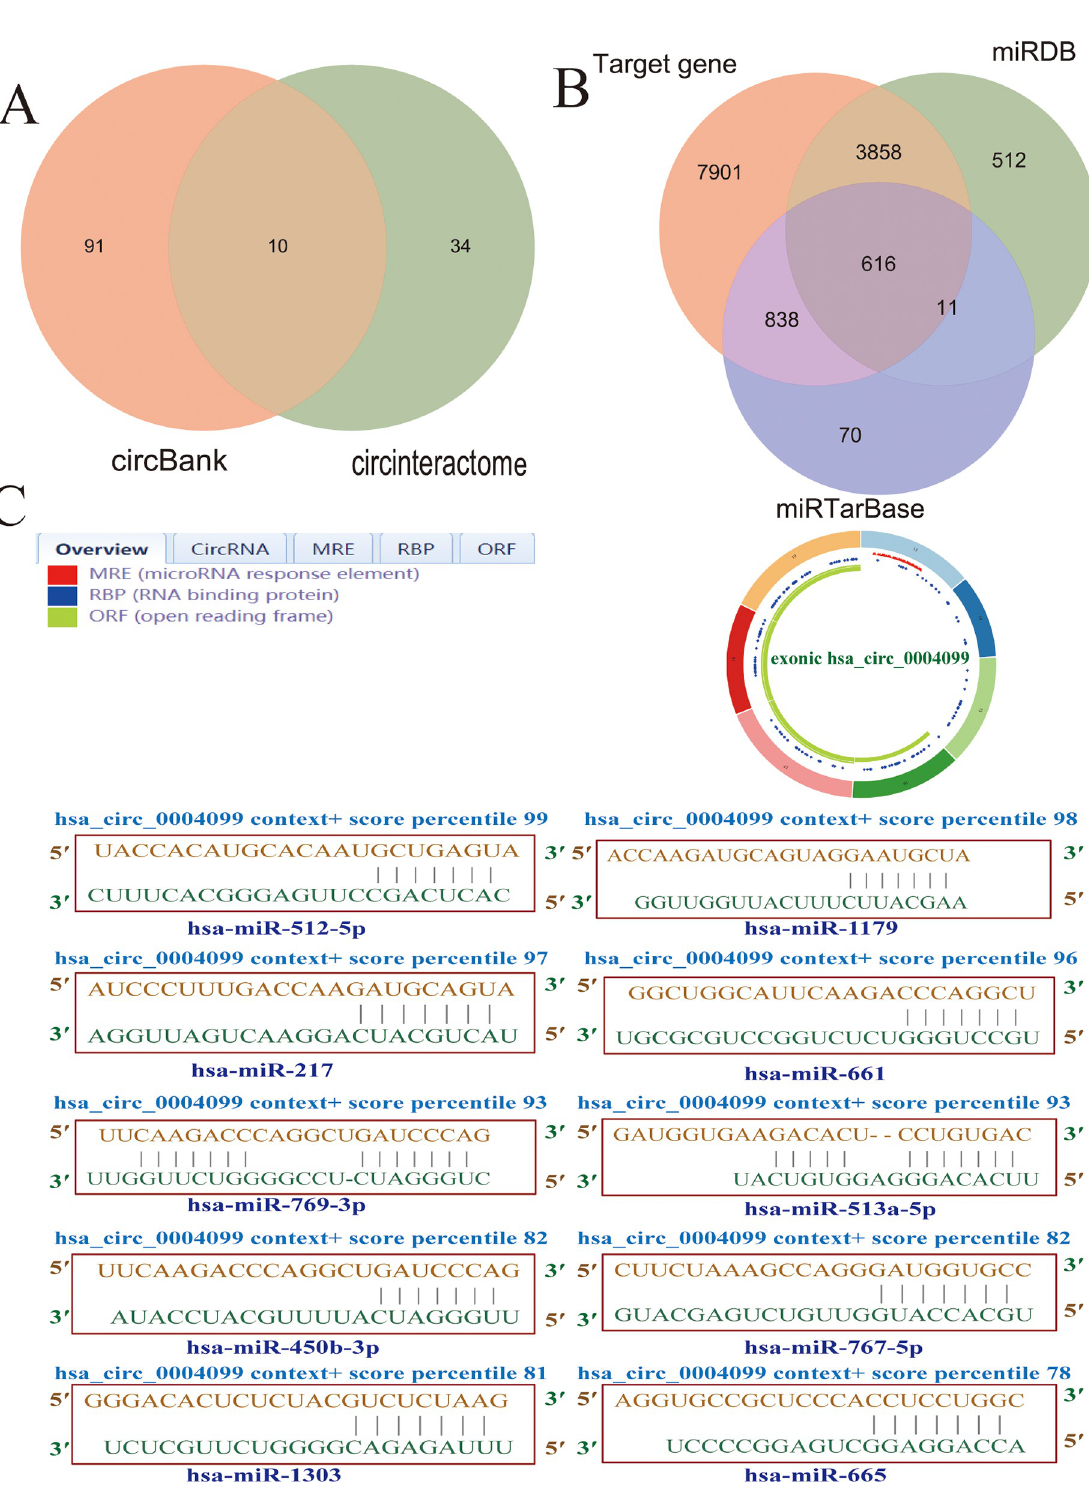
PLOS ONE | https://doi.org/10.1371/journal.pone.0277832 November18,